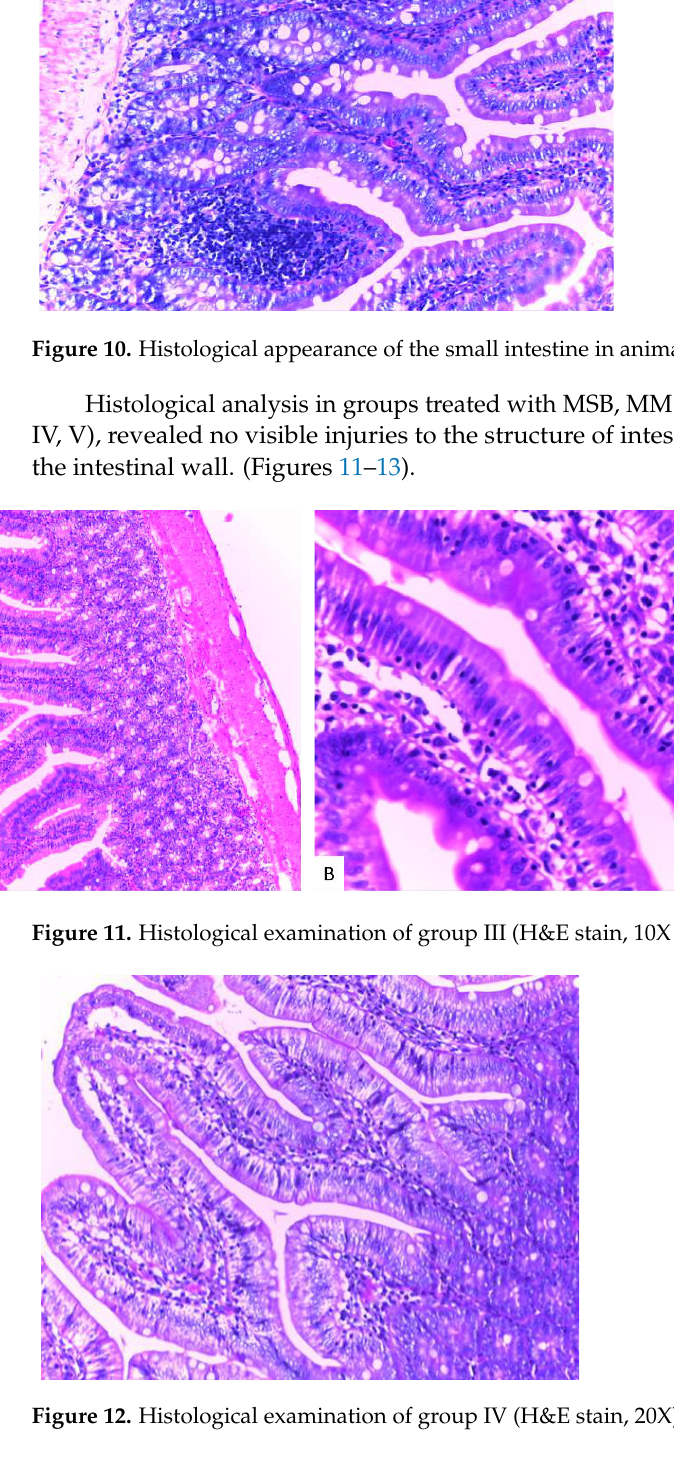
Figure 13. Histological examination of group V (H&E stain, 20X).